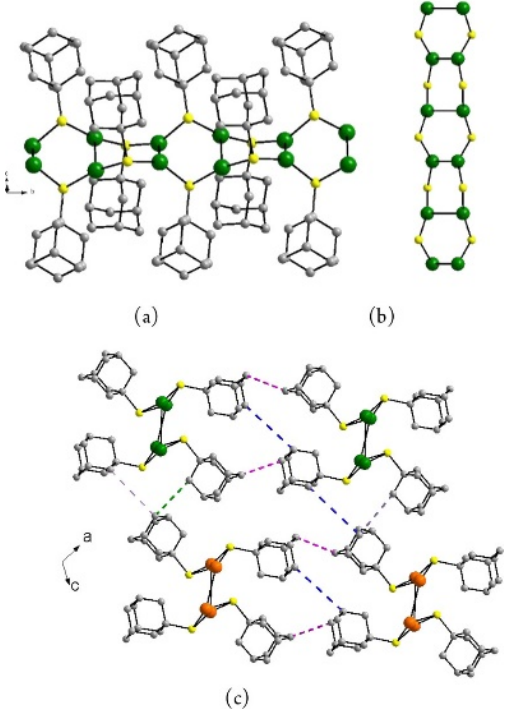
Figure 5. ( a ) One-dimensional Ag − S chain; ( b ) Ag − S connectivity creates a 6-membered ring; ( c ) One-dimensional chains are arranged in a two-dimensional supramolecular structure. Copyright 2015 American Chemical Society.